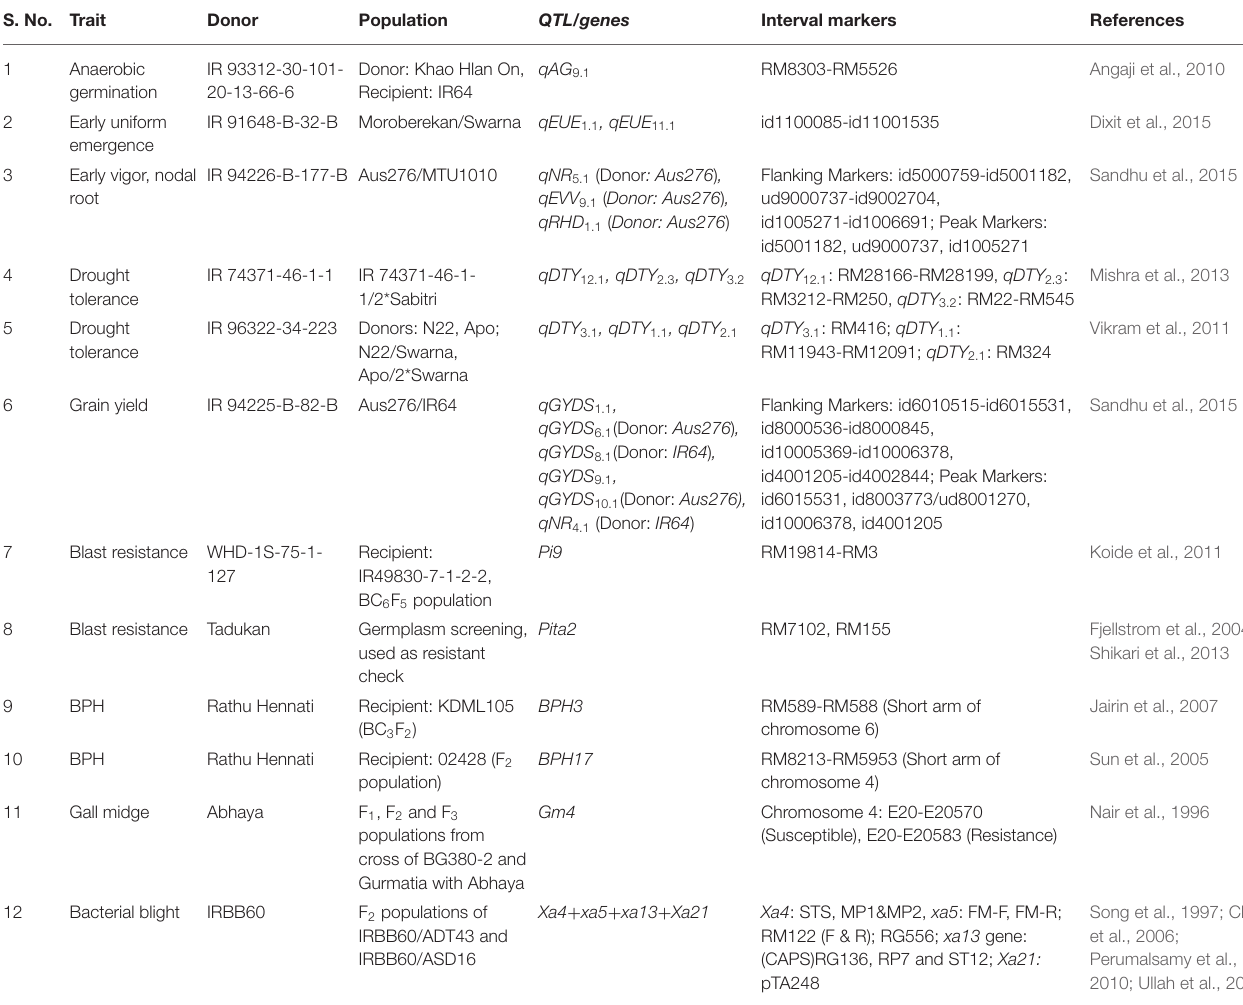
TABLE 2 | Detailed information on the donors and QTL selected and used in the genomics-assisted introgression study. S. No.